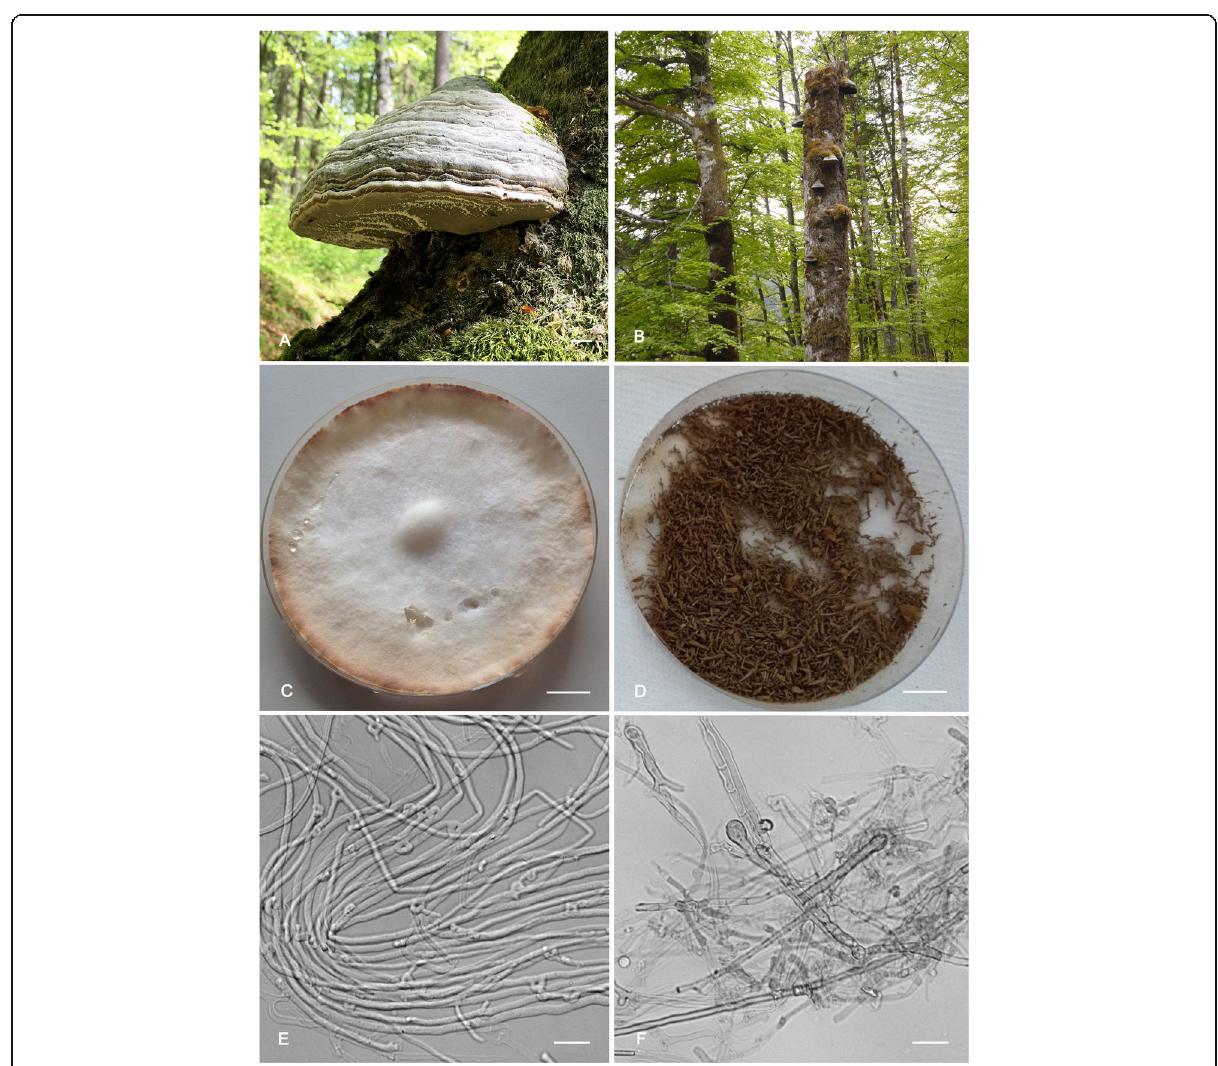
Fig. 4 Fomes fomentarius . A. Basidiome growing on Fagus sylvatica in Tyrol (Austria) (IB20170012). B. Several basidiomes growing on a dead stem of Fagus sylvatica . C. Mycelia pure culture (IB20130016) after 10 d on 3% MEA at 25 °C. D. Ground basidiome (IB20170012); note the dark brown colour and granular consistence. E. Generative hyphae with clamp connections (IB20130016) as formed after 5 d on 3% MEA at 30 °C. F. Inflated intercalary and terminal hyphal elements (IB20130016) after 5 d at 37 °C. Bars A, C-D = 1 cm; E-F = 10 μ